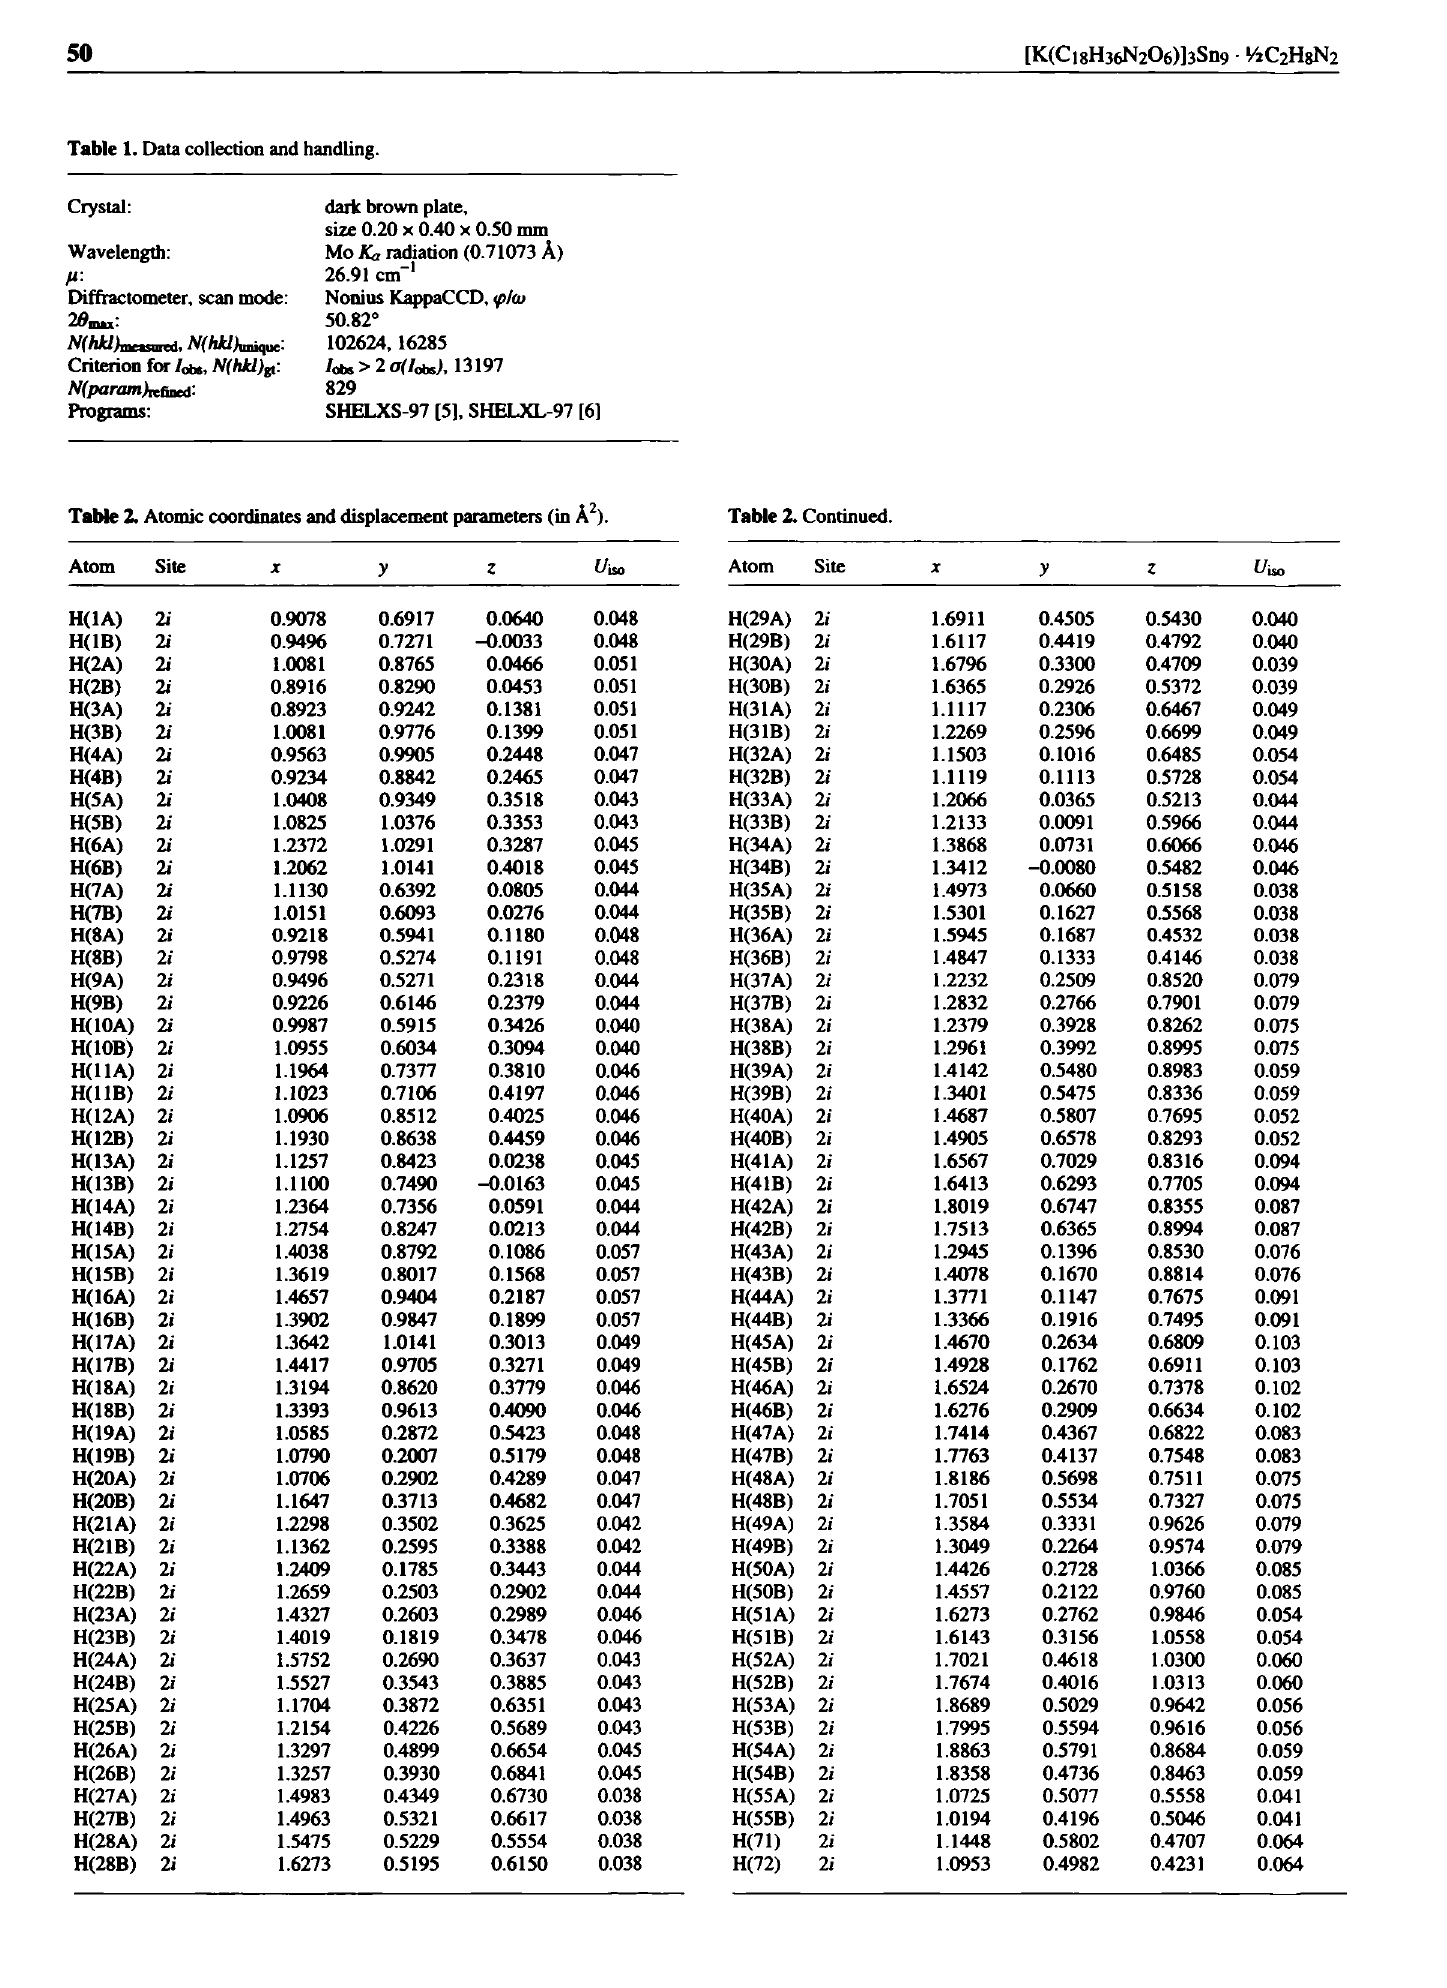
Table 1. Data collection and handling.